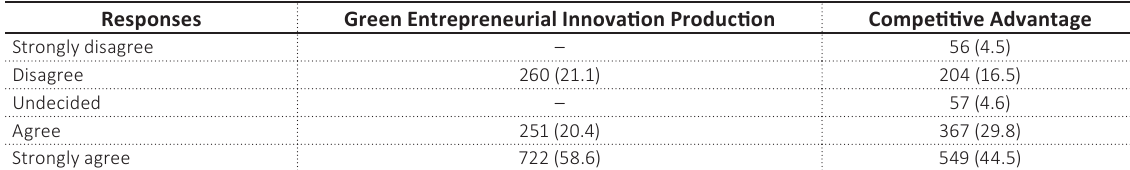
Table 10. Effect of green entrepreneurial innovation production on competitive advantage